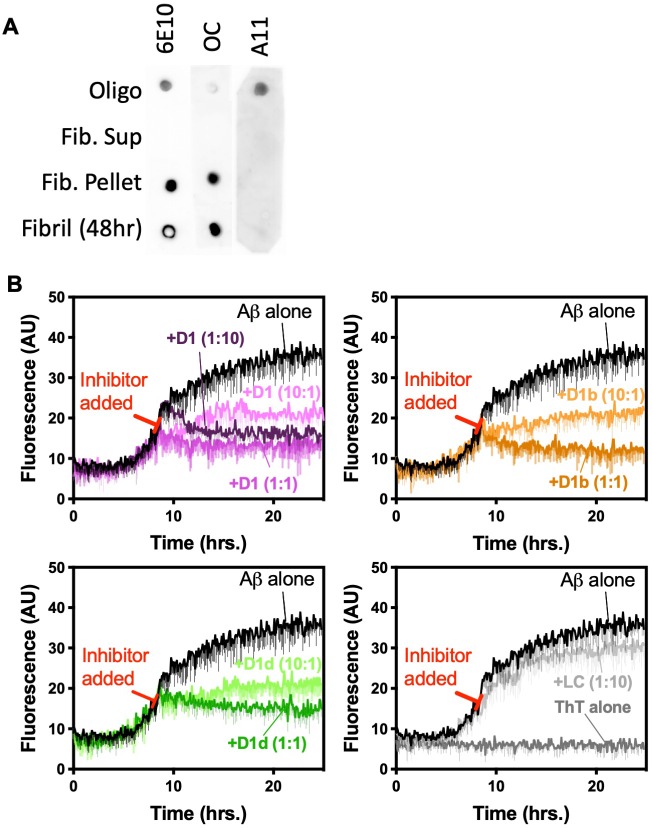
Aggregated Aβ conformations and inhibitor capping of Aβ fibrils.(A) Conformation testing of Aβ preparations. 10 μM Aβ1–42 was incubated for 12 hr at 37°C in oligomer preparation, or 48 hr at 37°C with shaking for fibril conditions Fibrils were spun down at 50,000 rpm for 30 min. Samples were spotted on nitrocellulose membranes and probed with A11, OC and 6E10 antibodies. (B) Peptide inhibitors D1, D1b, and D1d reduce fibril elongation of Aβ1–42, while negative control peptide LC does not. 10 μM of Aβ1–42 was incubated alone until approximately half maximal ThT (19 A.U.) was observed under quiescent conditions at 37°C in polypropylene plates. Inhibitors were added at a 1:10, 1:1, or 10:1 molar ratio to Aβ1–42 reactions at 8.5 hr as indicated by red bar. Fibril formation was monitored using ThT fluorescence. Curves show the average of three technical replicates with one standard deviation below.